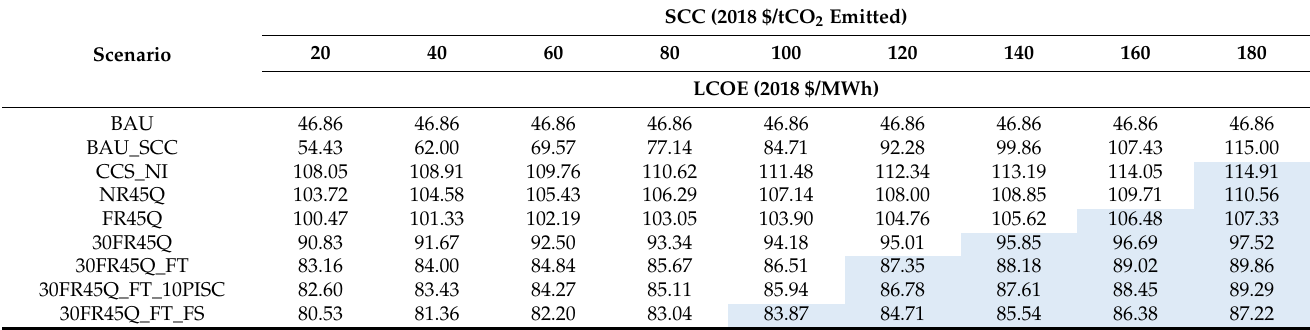
Table A7. LCOE (2018 $/MWh) for 727-MW NGCC scenarios.